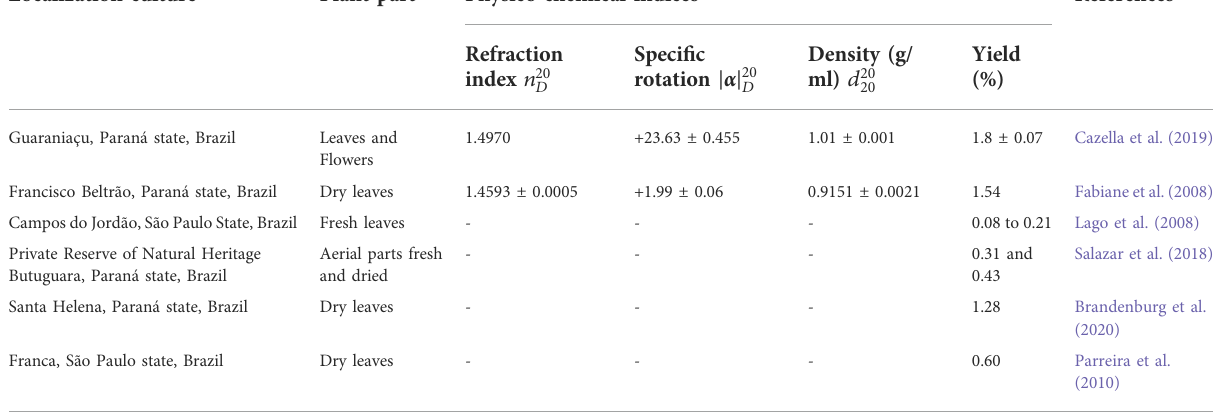
TABLE 1 Physico-chemical indexes of Baccharis dracunculifolia essential oil. Localization